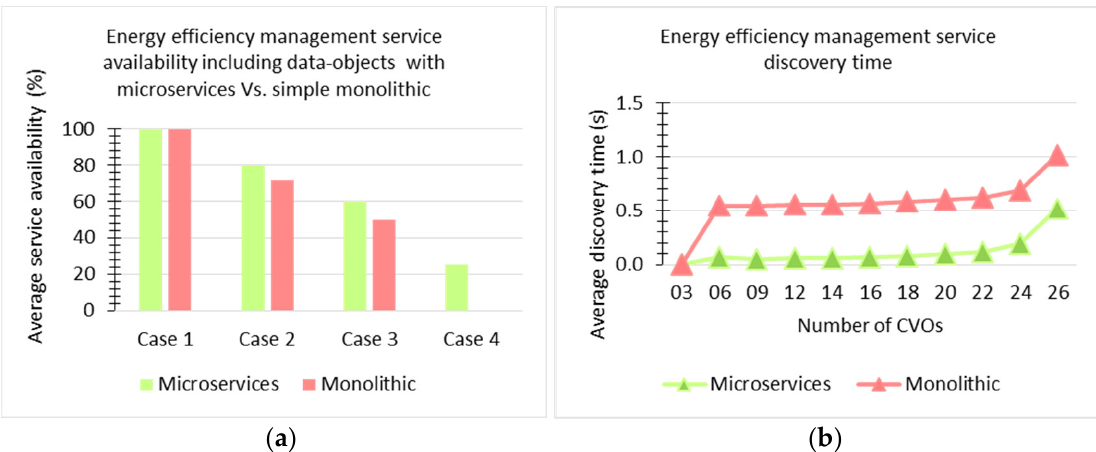
Figure 12. ( a ) Comparison of energy efficiency management service availability in microservices vs. monolithic, and ( b ) Comparison of energy efficiency management service discovery time in microservices vs. monolithic with a number of CVOs.